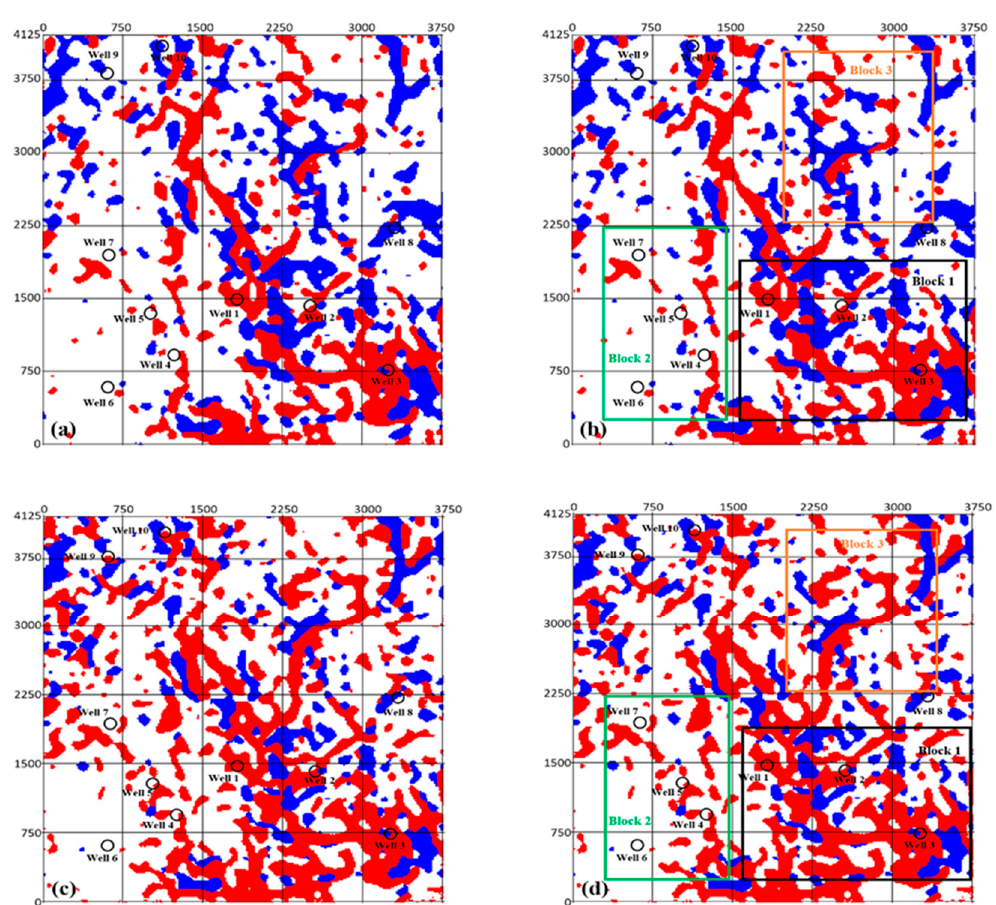
Figure 7. A comparison of the reservoir distribution by the 35 Hz single-frequency data and the full-band data. ( a ) and ( c ) are the direct results of the waveform cluster, while ( b ) and ( d ) are the interpretation of the cluster results. ( a ) and ( b ) are the full-band data, while ( c ) and ( d ) are the 35 Hz single-frequency data.